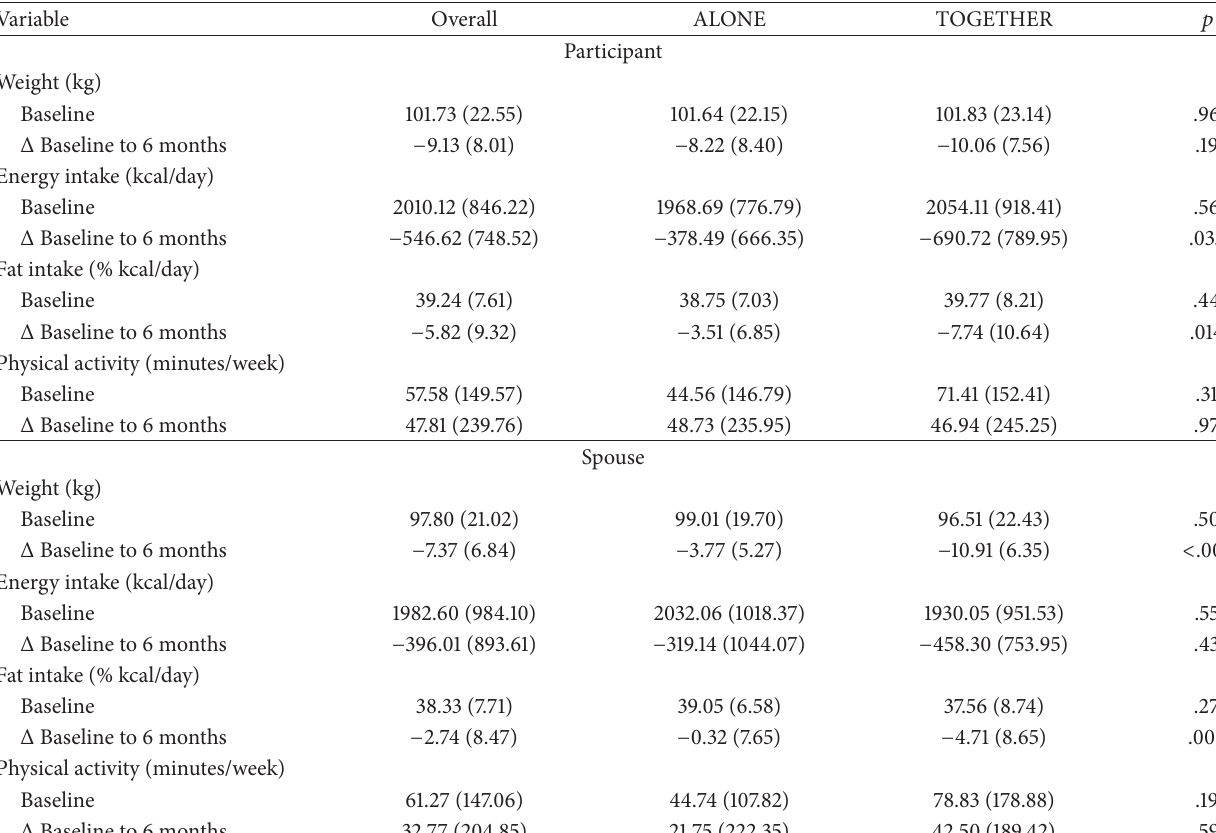
Table 2: Weight and behavior changes by treatment group, mean (SD).